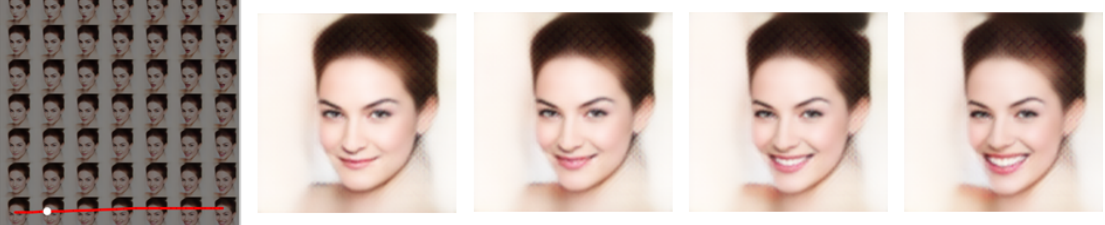
Figure 9. Example of smiling animation in the conceptual space [60]. Similar animation could be obtained for comics images. Image downloaded from the online demo